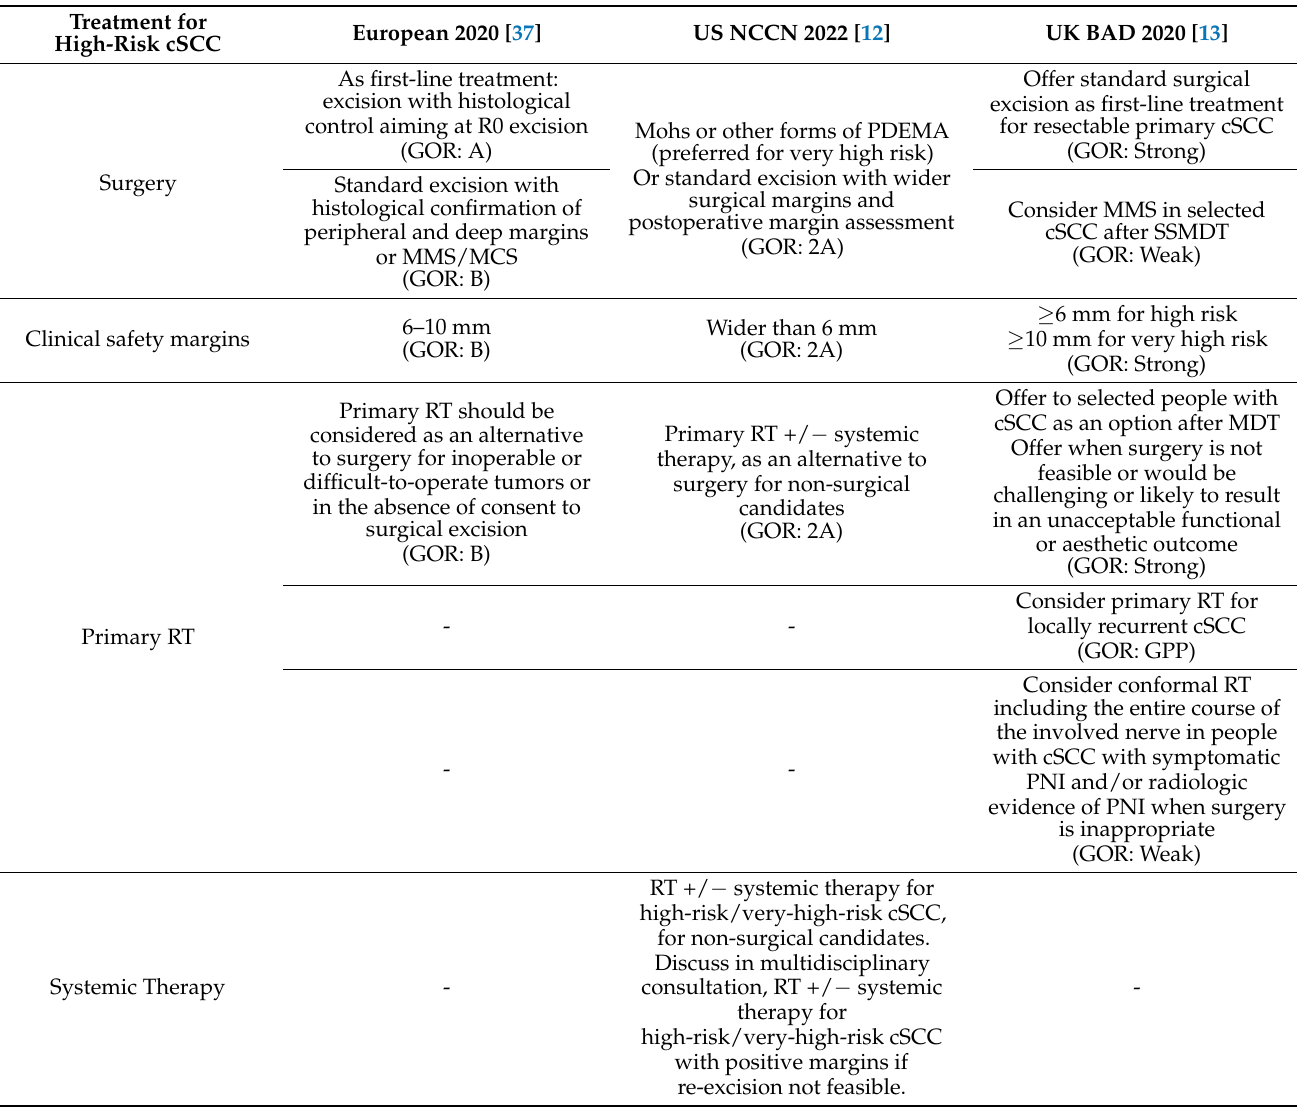
Table 3. Recommendations for the management of high-risk cSCC in current